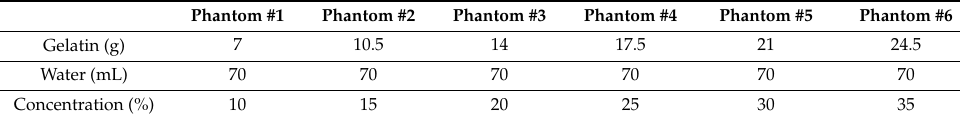
Table 2. Gelatin-based phantoms with various different concentration.